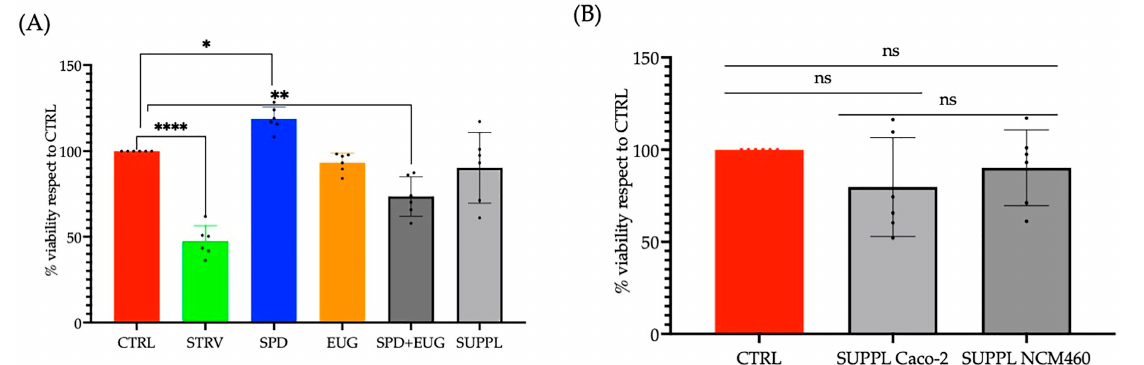
Figure 3. ( A ) The effect of 1.2 µ M spermidine (SPD) and 0.2 mM eugenol (EUG) alone, in combination (1.2 µ M SPD + 0.2 mM EUG), and in supplement (SUPPL) form (1.2 µ M SPD + 92 µ M EUG), respectively, on cell viability (MTT assay) in NCM460 cells compared to the untreated control (CTRL). ( B ) The effect of the SUPPL on cell viability in Caco-2 and NCM460 cells compared to the respective controls. Significant differences were represented as follows: ns p ≥ 0.05, * 0.01 < p < 0.05, ** 0.001 < p < 0.01, **** p < 0.0001. The black dots indicate the positioning of the individual replicates within the bar for each sample.